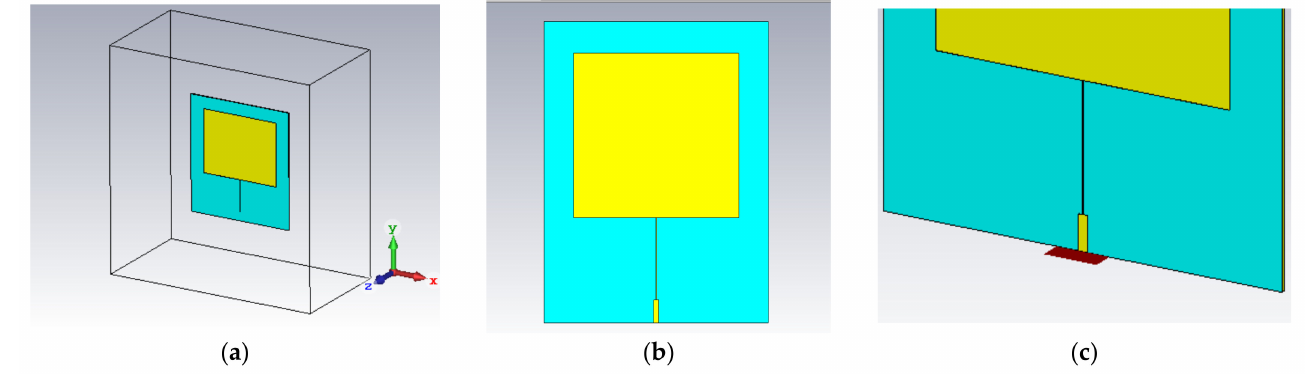
Figure 10. ( a ) Transmission line, ( b ) design of the patch antenna, and ( c ) power